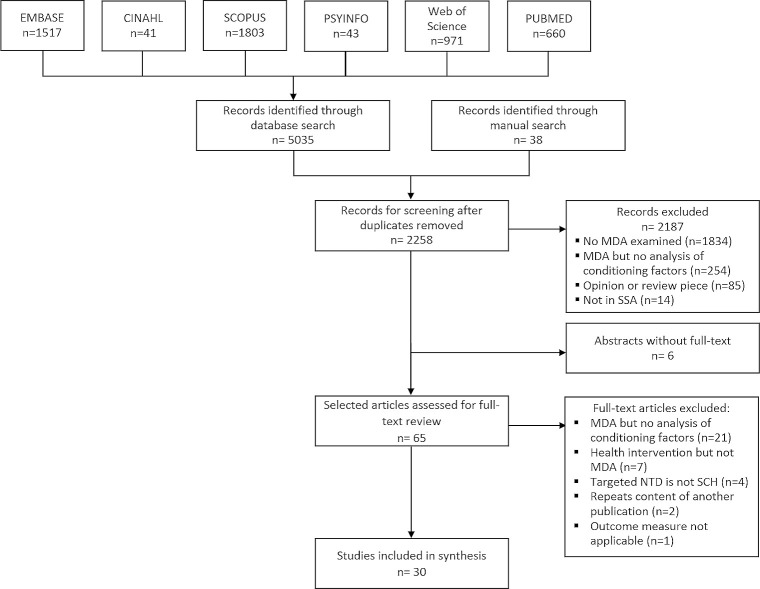
PRISMA flow diagram.